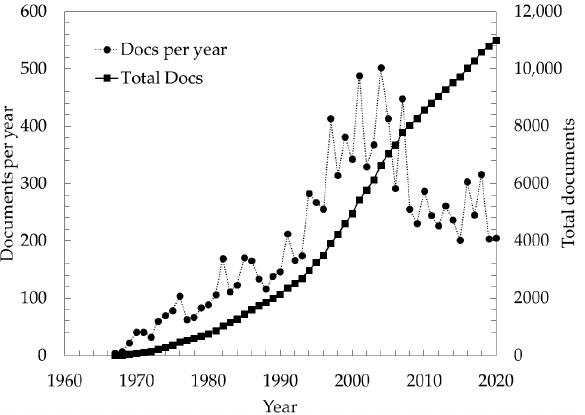
Figure 1. Scopus-indexed documents per year containing the keyword “superplastic” or “super- plasticity”.